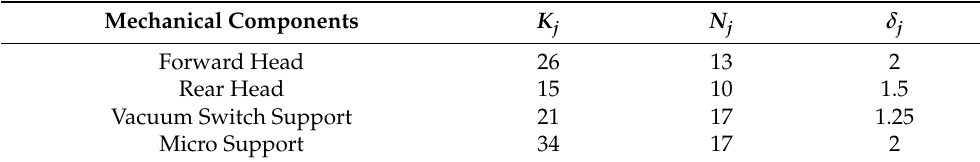
Table 6. Manufacturing data collected for the product Model A at level 2. Number of interfaces for the analyzed subcircuits ( K j ) [count], number of mechanical components at the interface with the subcircuit ( N j )